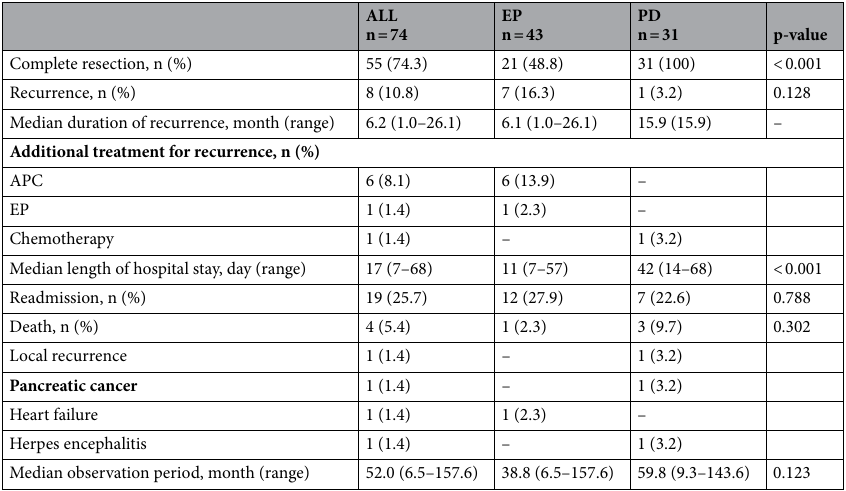
Table 5. Clinical outcomes. APC algon plasma coagulation, EP endoscopic papillectomy, PD